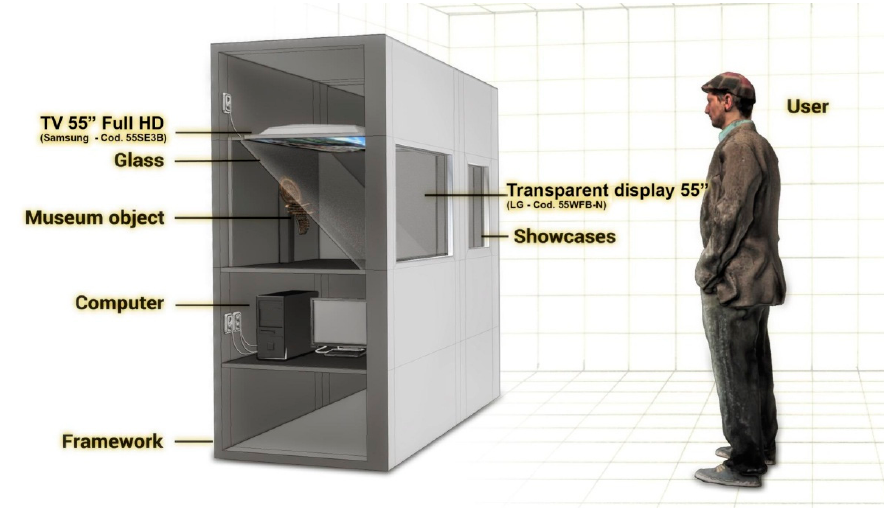
Figure 4. Technical scheme of a Pepper’s Ghost digital setup for museums.